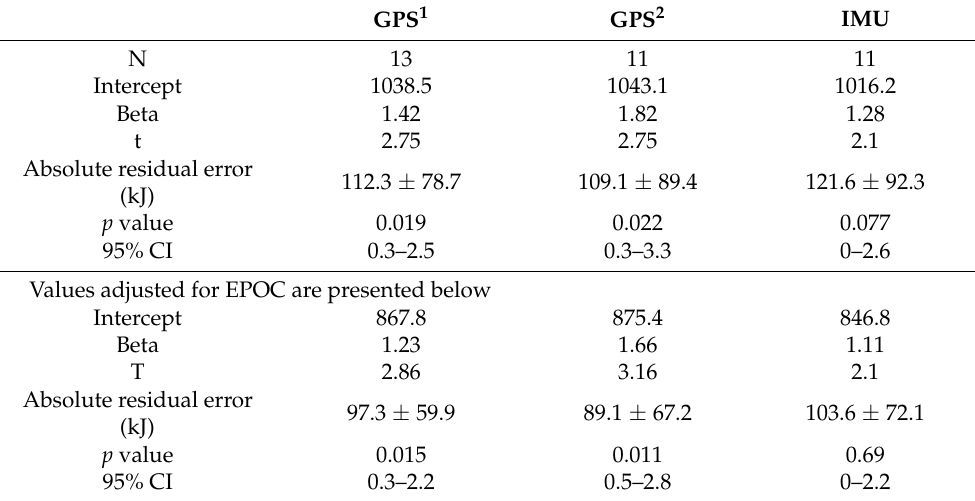
Table 2. Display regression coefficients representing the mean change for specific devices as predicted by the regression model, compared against the criterion measure VO 2 . The first part of the table displays the values for total EEE, with the second part showing values adjusted by removing EPOC measurements, only analyzing moving time.